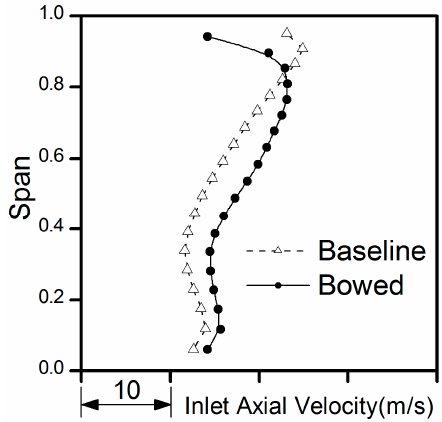
Figure 11. Stacking lines sketch and blade shapes of stator 5. SS : suction side; PS : pressure side.